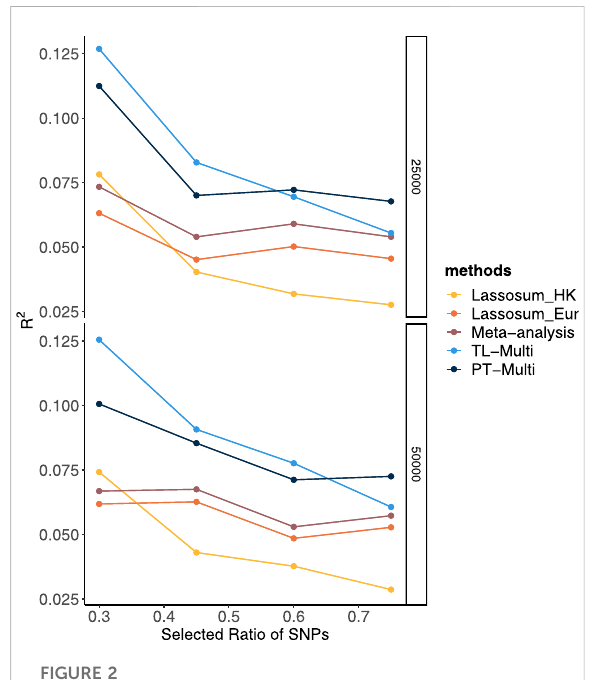
FIGURE 2 Prediction accuracy of Lassosum, meta-analysis, PT-Multi, andTL-Multiover20replicationsinsimulations.Theselected ratio of SNPs was the ratio of the actual numbers of SNPs simulated to the total number of common SNPs (69,398). The actual numbers of SNPs simulated in the four scenarios were 21,477 (chromosomes 1 – 4), 32,151 (chromosomes 1 – 6), 39,682 (chromosomes 1 – 8), and 49,909 (chromosomes 1 – 11), respectively. The average of R 2 was plotted. Upper: The sample size of the European population is 25,000, and the sample size of the Hong Kong population is 1,000. Lower: The sample size of the European population is 50,000, and the sample size of the Hong Kong population is